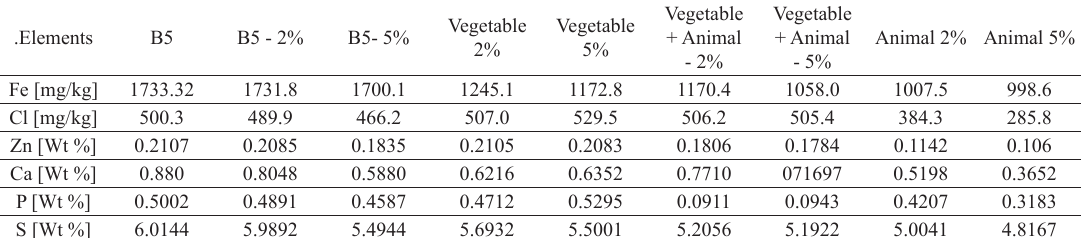
Table 6. X-ray spectrometer